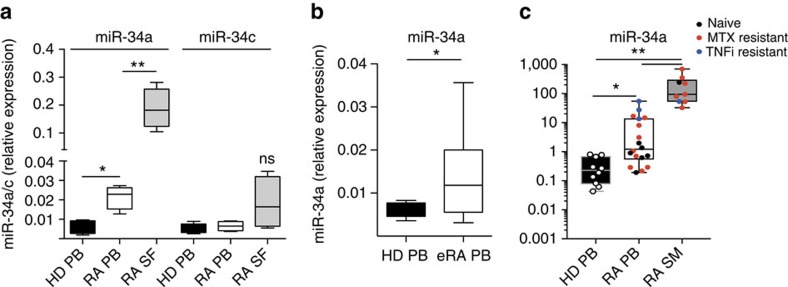
MiR-34a expression is upregulated in DCs from patients with RA.(a) CD1c+ DCs were FACS-sorted from PB of healthy donors (HD, n=6), and from PB (n=6) and SF (n=6) of RA patients with established RA of >2 years duration. Compared to HD, miR-34a expression was upregulated in PB CD1c+ in RA patients (*P<0.05, Mann–Whitney U-test); and further upregulated in matched SF (**P<0.01, paired t-test). There was no significant difference (ns) in miR-34c expression between these groups. (b) miR-34a expression was upregulated in PB CD1c+ cells in patients (n=14) with early RA <6 months from diagnosis (eRA), as compared to age-matched HD (n=6) (*P<0.05, Kolmogorov–Smirnov test). (c) MiR-34a expression was upregulated in CD1c+ DCs FACS sorted from dispersed RA synovial membrane (SM, n=9) as compared to RA PB (n=19) and HD PB (n=10) cells (**P<0.01 Kruskal–Wallis test and Dunn’s multiple comparison test). Data presented as median and inter-quartile range boxplots; and for c, each dot represents single sample from naive (naive-to-treatment); MTX resistant (resistant to methotrexate treatment); TNFi resistant (resistant to combined therapy of methotrexate and TNF inhibitors). Demographic and clinical information for samples in a–b is presented in Supplementary Table 1 (Cohort 1); and for samples in c is presented in Supplementary Table 2 (Cohort 2). ns, nonsignificant.